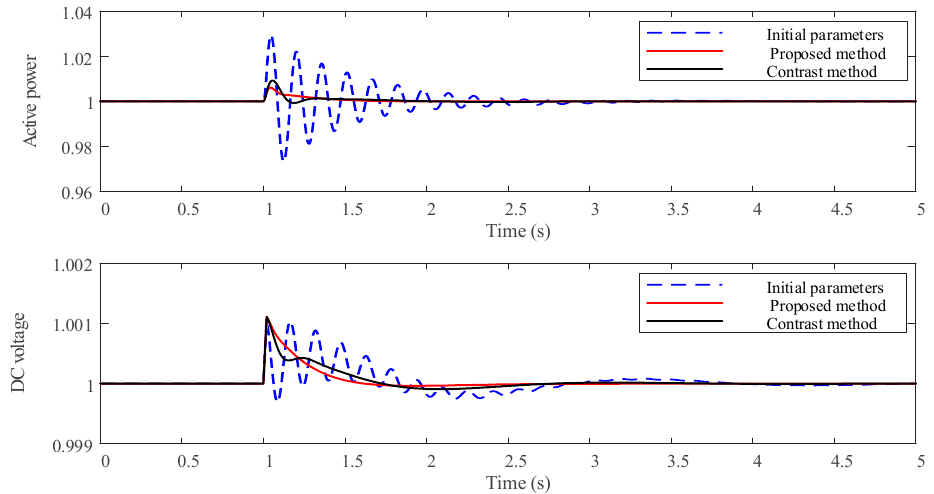
Figure 5. Active power and DC voltage of the PV-VSG with small disturbance.